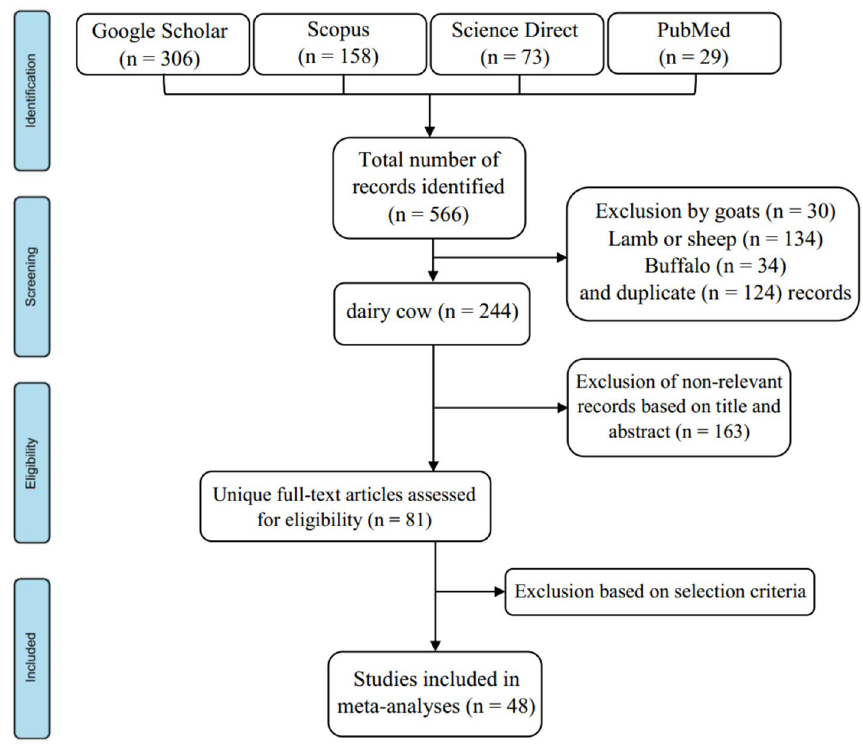
Figure 1. Flowchart of the literature search, identification, and screening process for selecting studies (search conducted from April 2021 to October